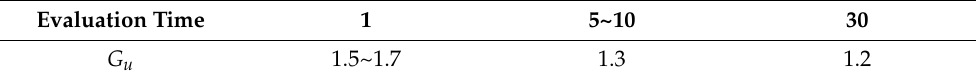
Table 4. The relationship between the evaluation time of the instantaneous wind speed and G u .